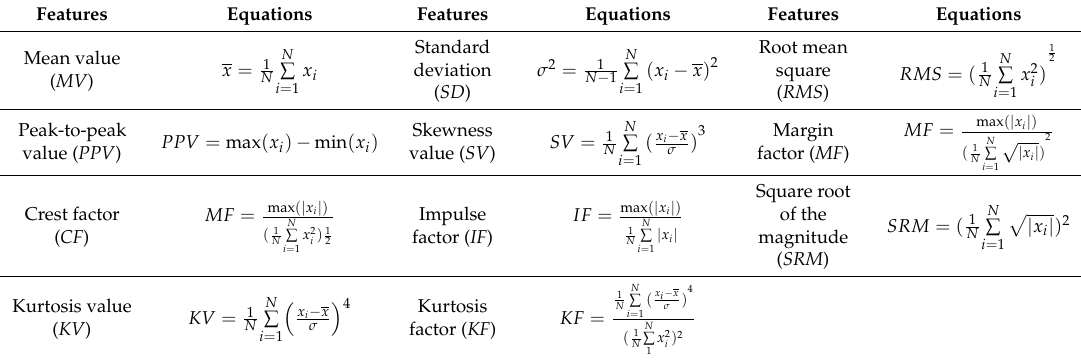
Table 1. Time domain statistical features ( x is the vibrational